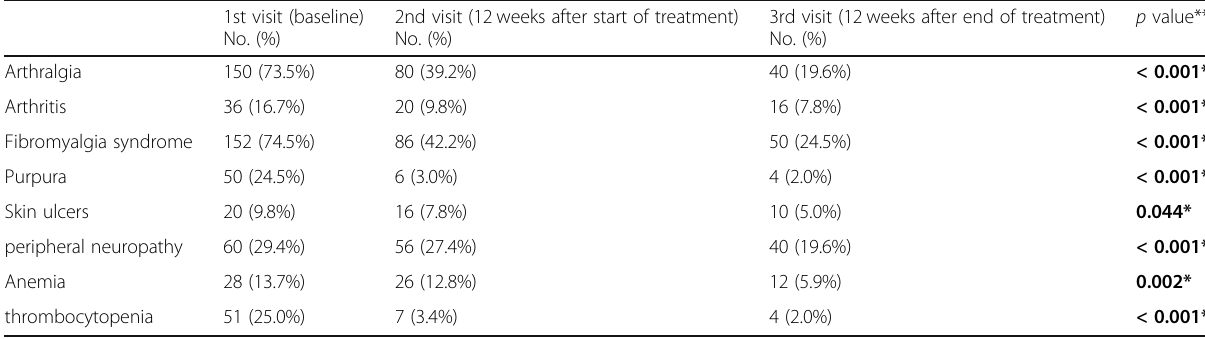
Table 3 Comparison of extra-hepatic manifestations in follow-up visits 1st visit (baseline) 2nd visit (12 weeks after start of treatment) No. (%) No. (%)